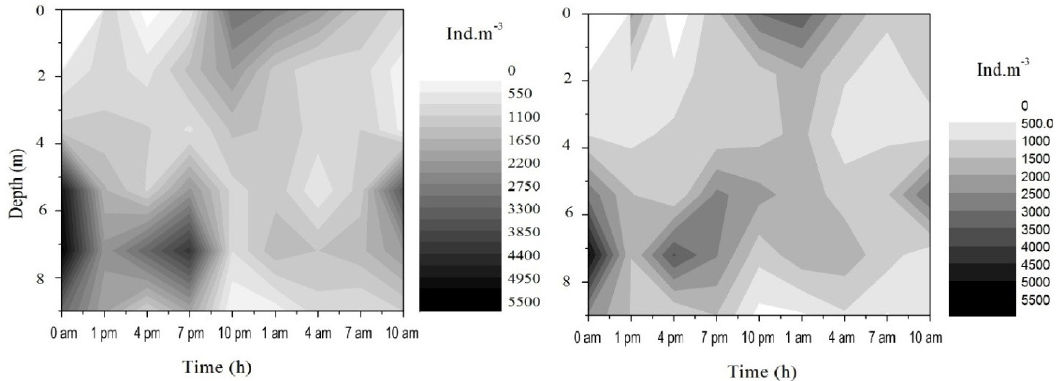
Figure 3. Vertical variation in population density of Ceriodaphnia silvestrii and Ceriodaphnia cornuta (ind.m -3 ) during a single nictemeral cycle, at a study station in Furnas Reservoir, from 10 am January 15, to 10 am of January 16, 2014.